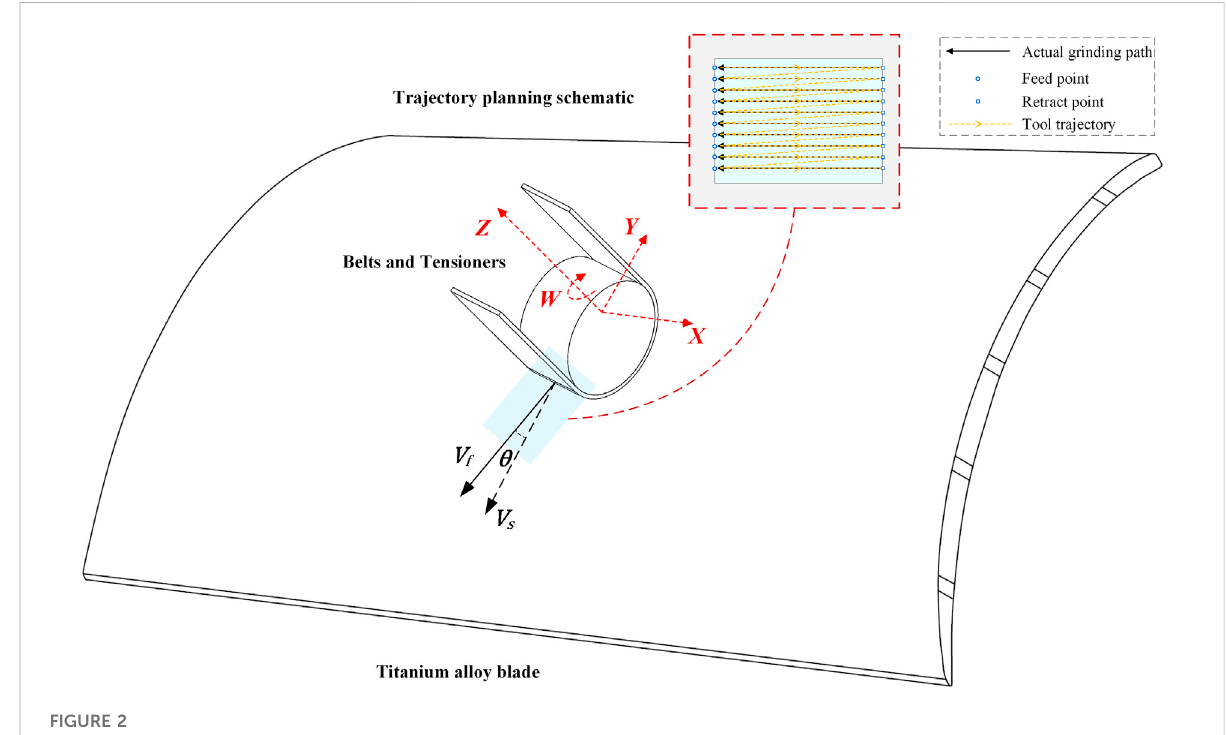
FIGURE 2 Schematic of grinding trajectory